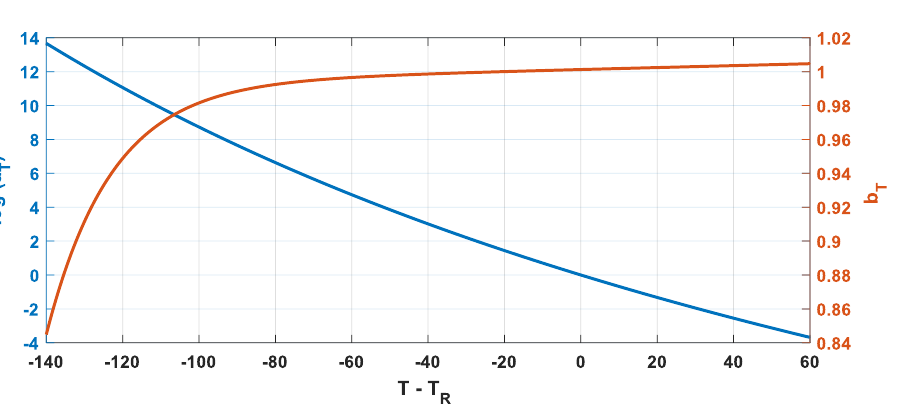
Figure 4. Typical trend of a T and b T .